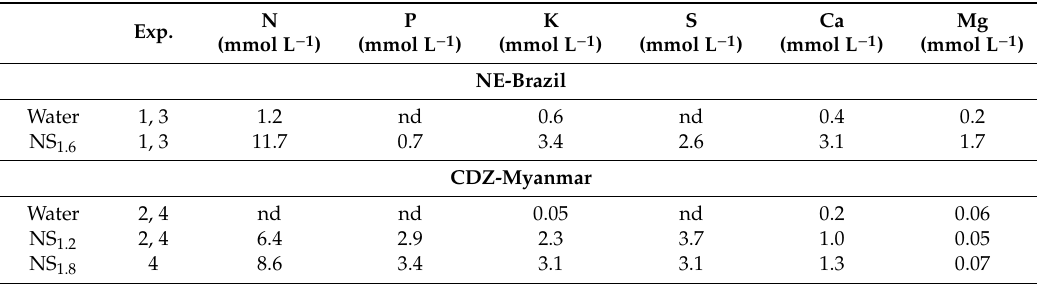
Table 1. Macronutrient concentrations in water and nutrient solutions (NS) adopted in the experiments in NE-Brazil and in CDZ-Myanmar.